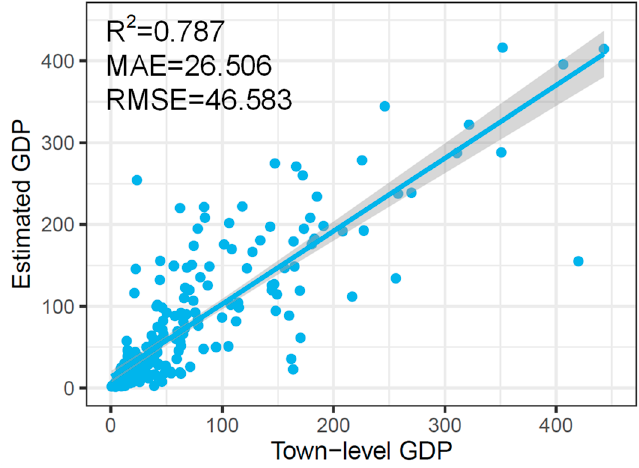
Figure 10. Accuracy of gridded total GDP data evaluated by town-level GDP data.